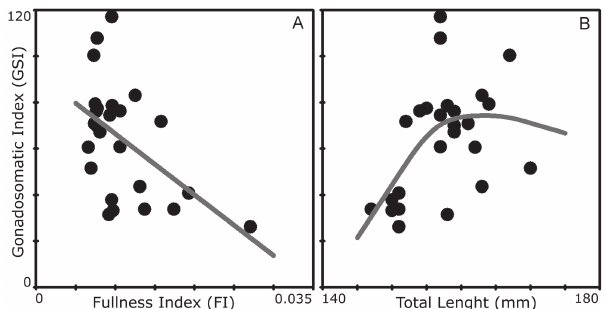
Fig. 5. Relation between gonadosomatic index with fullness index (A) and with total length (B) of Cetengraulis edentulus in Guanabara Bay. Lines represent the generalized additive models selected by the Akaike information